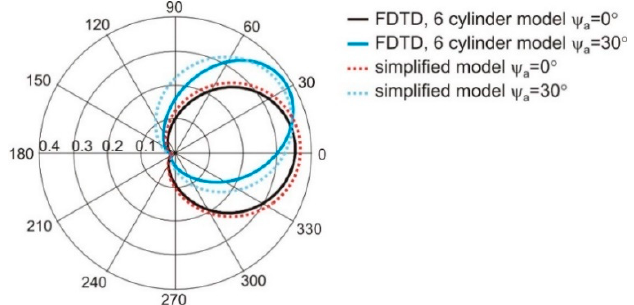
Figure 4. The radiation pattern of a single wearable antenna obtained with the simplified model given in Equation (1) compared to the results of simulations with the FDTD method and cylindrical model of the body.